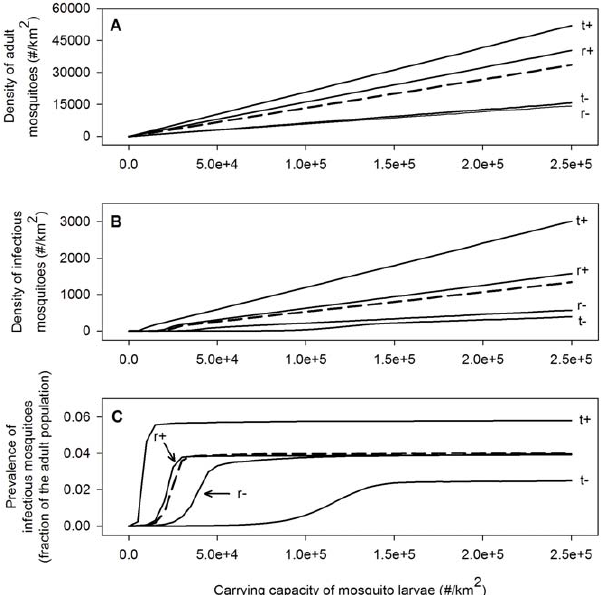
Figure 3. The mean annual densities of adult and infectious mosquitoes and the mean annual prevalence of infectious mosquitoes as a function of larval the carrying for different mid-elevation climate scenarios. The dashed line represents a climate with a mean annual temperature of 17 u C and an average yearly rainfall of 3000 mm. The other climate scenarios are derived from this scenario by increasing or decreasing the daily temperatures and rainfall. The mean annual temperatures and average yearly amounts of rainfall for these scenarios are 15.5 u C and 3000 mm (t 2 ), 18.5 u C and 3000 mm (t + ), 17 u C and 2000 mm (r 2 ) and 17 u C and 4000 mm (r +